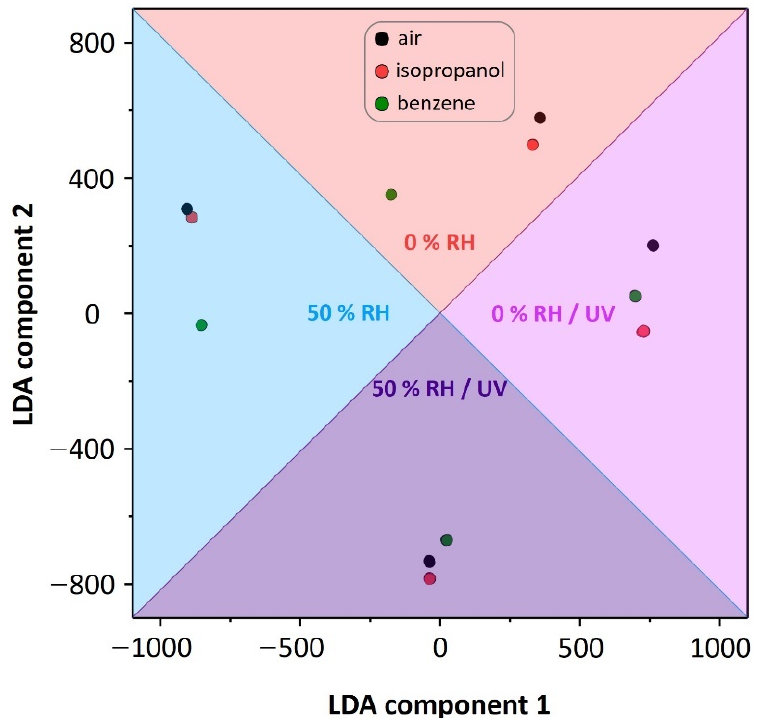
Figure 7. The LDA diagram of primary two components related to multi-dimensional sensor signals of ZnO nanostructured layer-based chip upon exposure to isopropanol and benzene vapors, 10 ppm, in dry and humid air conditions when UV is On and Off. The clusters of the vector signals related to reference air backgrounds are given for clarity, too. The chip operating temperature is 150 ◦ C. The cluster ellipses are built under the Gaussian distribution of signals within each class at 0.99 confidence probability. The number of vector signals related to each class under study is equal to 50.